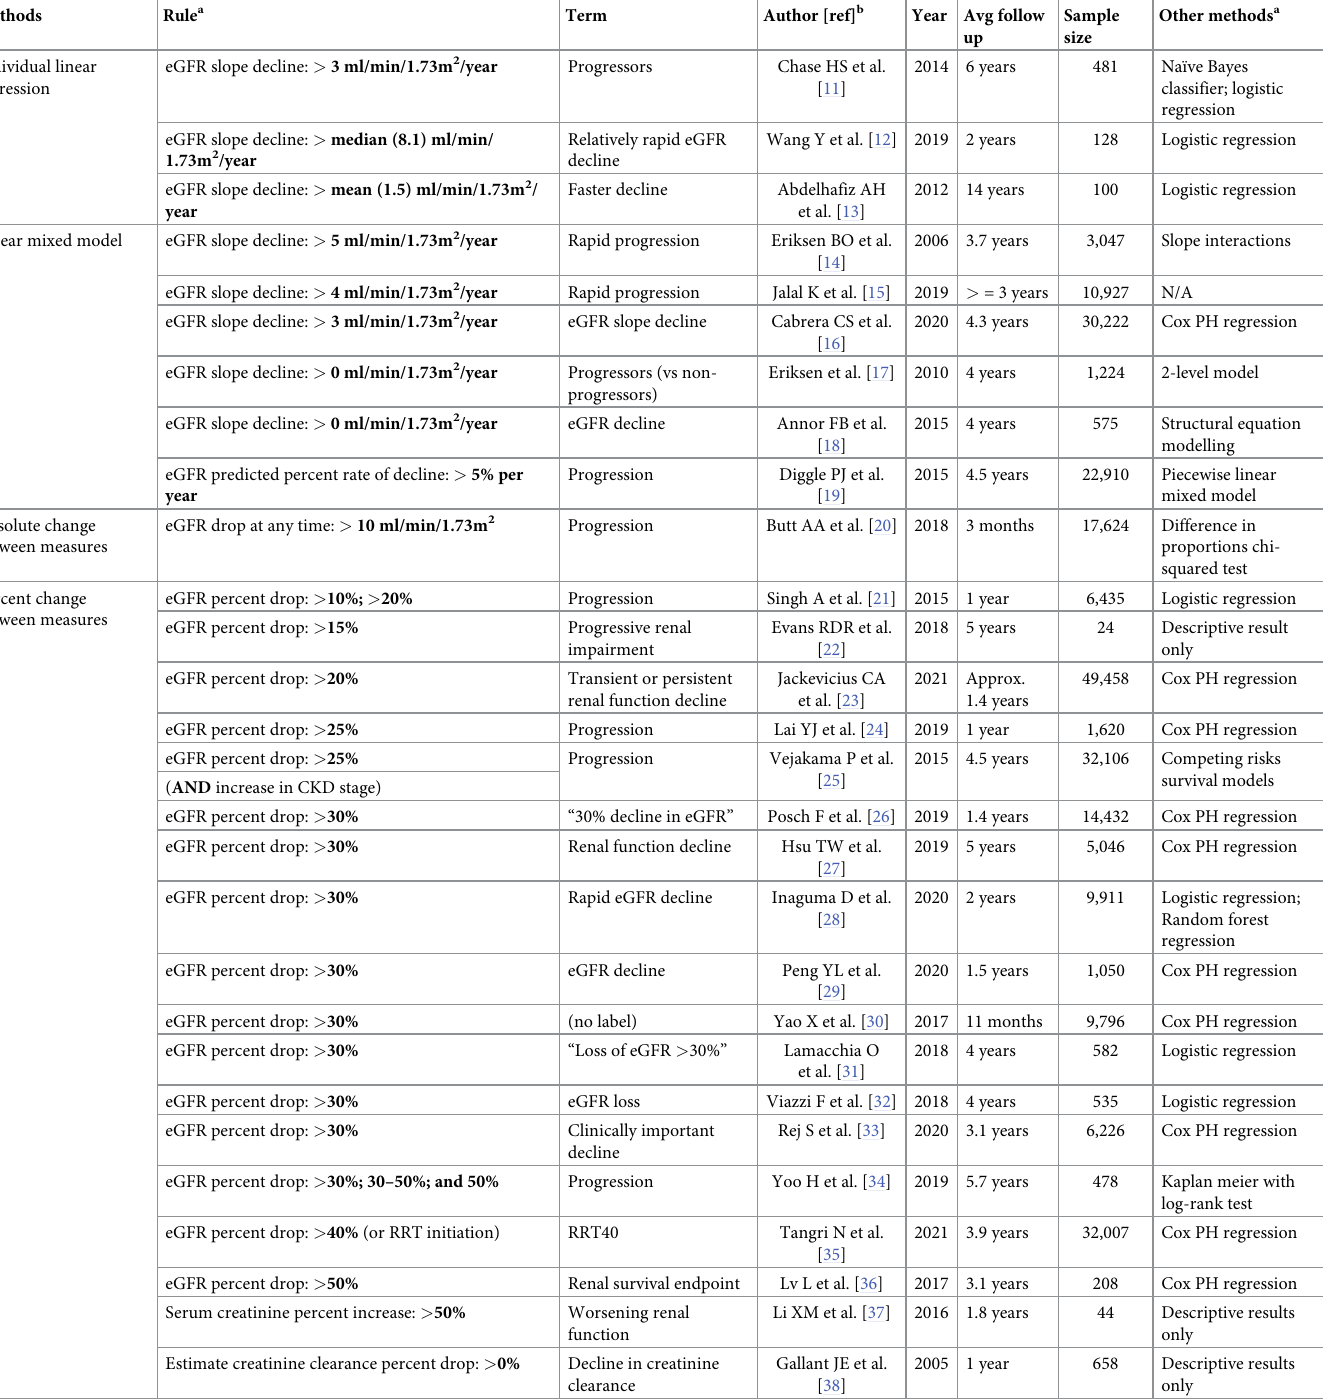
Table 4. Listing of CKD progression measures in reviewed articles (52 of 80